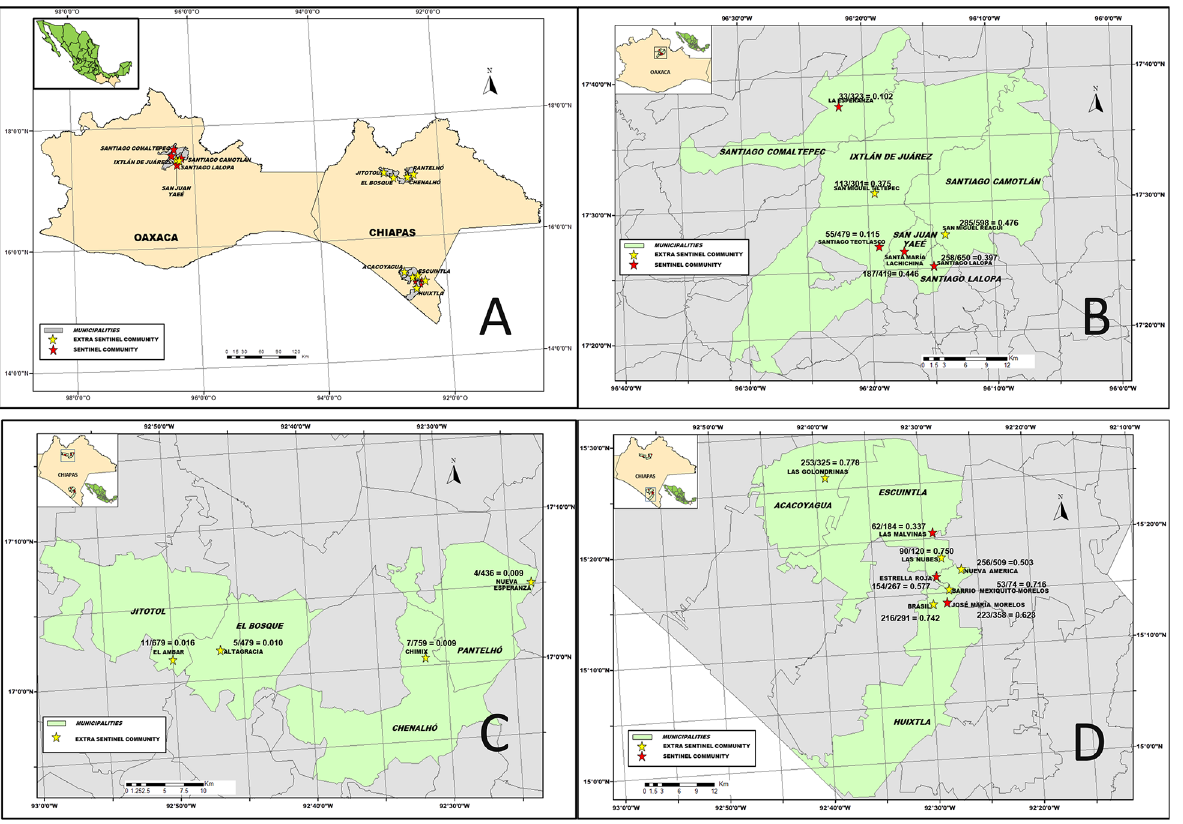
Fig 1. Location, number of cases, and population at risk when ivermectin distribution began at the study sites: Panel A: Map of the Southern Mexico states showing the three endemic foci for onchocerciasis. Panels B-D: the eighteen sentinel and extra-sentinel communities in Oaxaca (Panel B; prevalence data from 1995), Northern Chiapas (Panel C; prevalence data from 1999), and Southern Chiapas (Panel D; prevalence data from